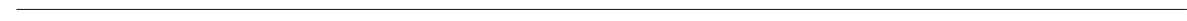
Fig. 7. Psammosteus livonicus Obruchev, topographic variability of the ornament ( 29 – 44 ); SEM photographs ( A , C – E ); 3D model of pulp canals based on microtomographic data ( B ). Serial arrangement of photographs is shown in Fig. 4. 29 – 32 , GIT 116-272, left branchial plate; 33 – 36 , PIN 1737/8, left branchial plate; 37 , 38 , GIT 116-273, right branchial plate, Pasta muiža, Latvia; 39 , PM SPU 71-6, fragment of branchial plate, Andoma Hill, Russia; 40 – 42 , PIN 1737/76, ridge scale; 43 , PIN 1737/9, ridge scale; 44 , GIT 25-12, dorsal plate; А , PM SPU 71-4, tubercles with varying degrees of abrasion, top view, Yam-Tesovo, Russia; B , 3D reconstruction of histological structure of specimen PM SPU 71-4; C , D , GIT 116-327, cyclomorial tessera from the ventral side of the branchial plate, Pasta muiža, Latvia; top (C) and lateral (D) view; E , PM SPU 71-5, tessera, lateral view, Yam-Tesovo, Russia. Note: Pasta muiža, Yam-Tesovo and member AG-1-2 in the outcrop N-2 at the Andoma Hill are the Upper Devonian, Amata RS localities. Scale bars: 29–33, 35–42, A–D = 0.5 mm; 34 = 2 cm; 43 = 0.2 mm; 44 = 2 mm. Abbreviations: c.tub., central tubercle; m.cr., marginal crenulations; m-tub., microtubercles; m-tub.ch., microtubercular chambers; p.c., pulp cavity; ram., ramification of marginal crenulations; r.p.can., radial pulp canals; r.r., radial ribs; s.tub., tubercles